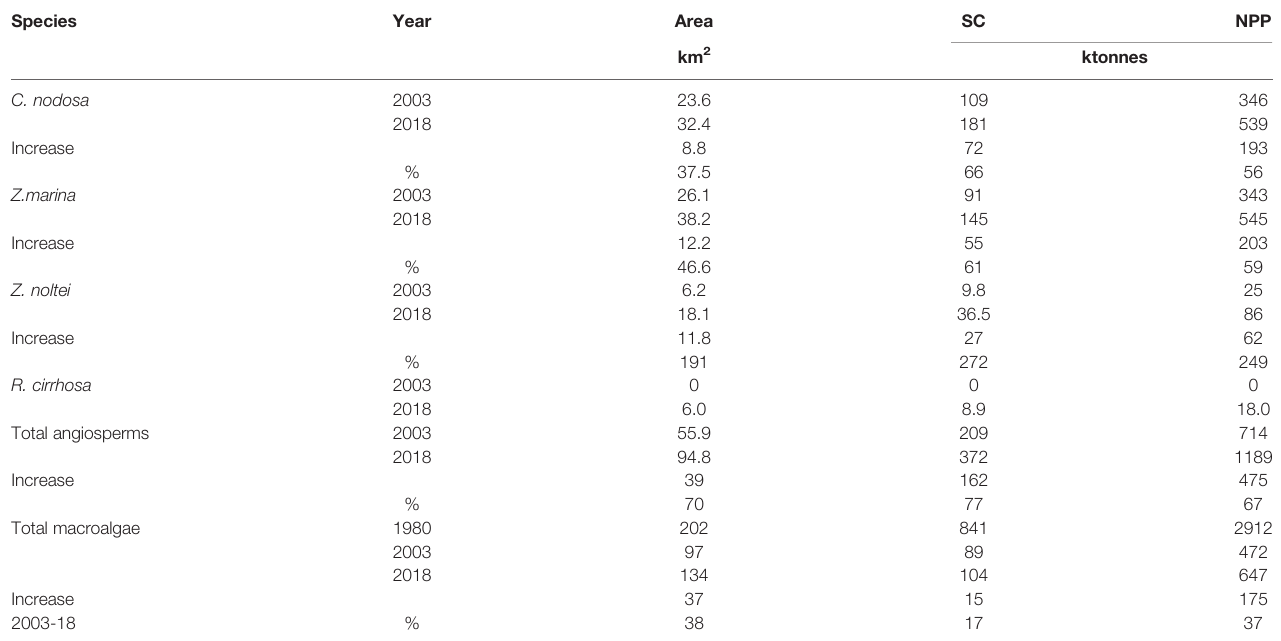
TABLE 4 | Macrophyte comparison in different years.